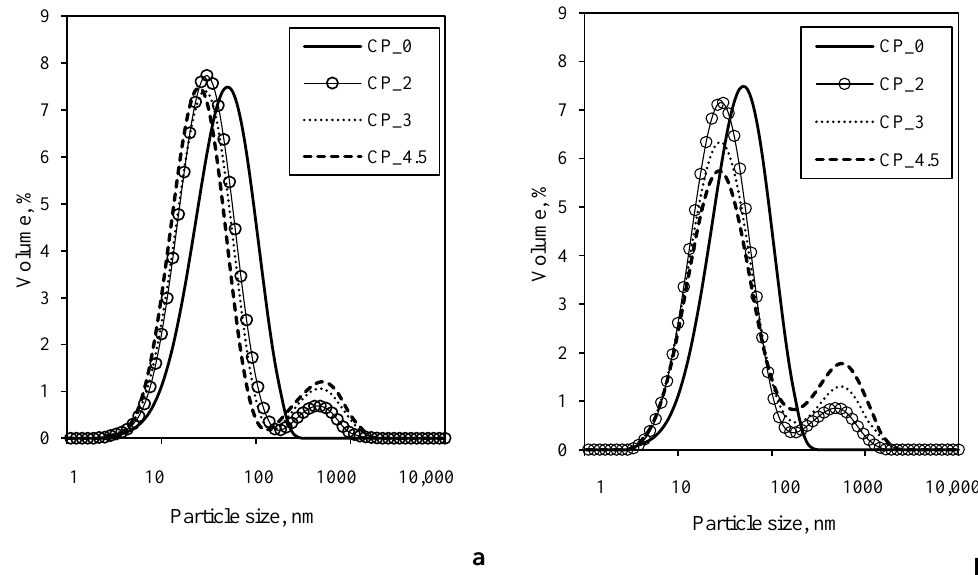
Figure 3 . Particle size and distribution of yogurt made by adding different Figure 3. Particle size and distribution of yogurt made by adding different amount of CP after ( a ) and amount of CP after (a) and before fermentation (b) before fermentation ( b ).